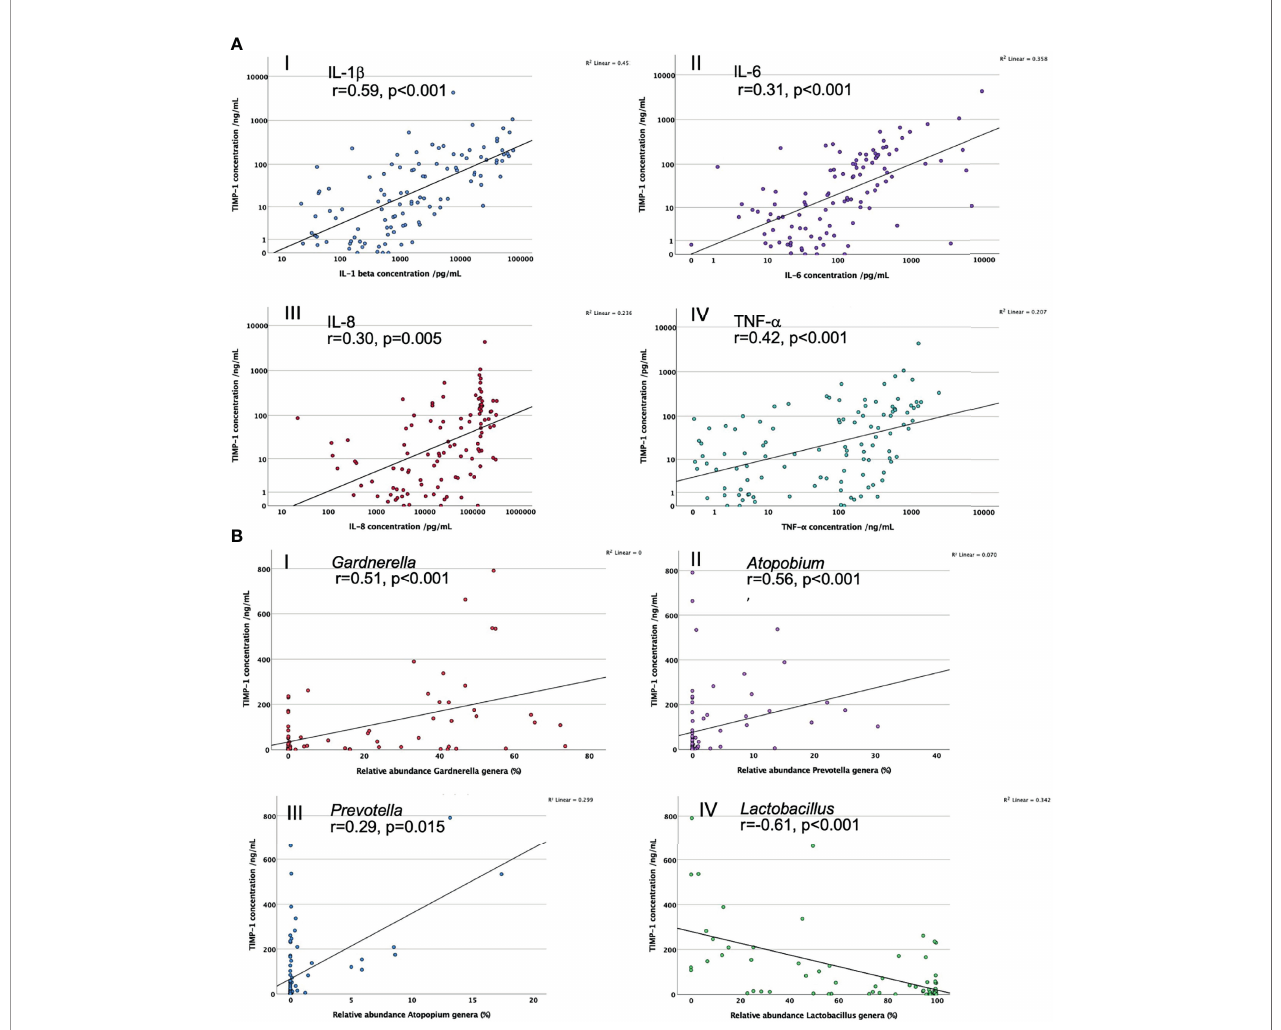
FIGURE 3 | (A) Scatter graphs to explore correlation of CVF MMP-9 concentrations with key CVF cytokine concentrations. I. IL-1 b ; II. IL-6; III. IL-8; IV.TNF- a . (B) Scatter graphs to explore correlation of CVF MMP-9 concentrations with proportions of key vaginal bacterial genera. I. Gardnerella; II . Atopobium; III. Prevotella; IV. Lactobacillus. r = correlation co-ef fi cient, controlled for maternal age, BMI and